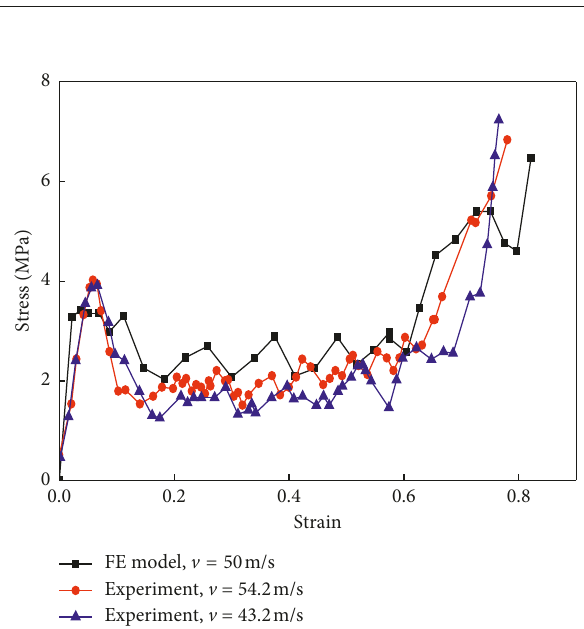
Figure 2: Stress-strain curves of honeycomb